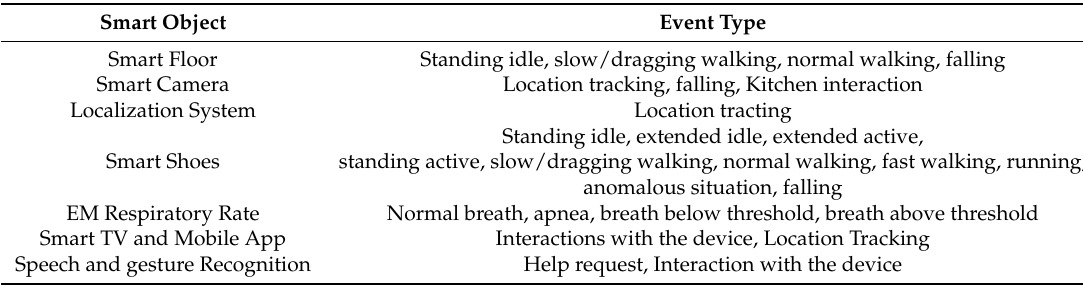
Table 1. Type of event detected by